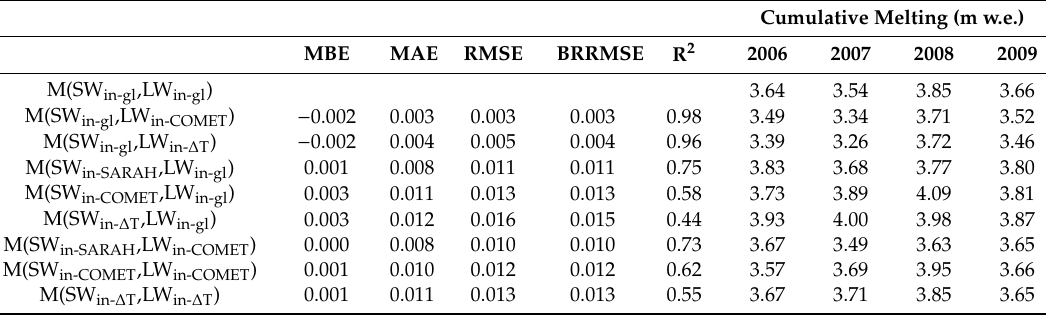
Table 3. MBE, MAE, RMSE, BRRMSE, and R 2 obtained comparing daily melt from Equation (11) estimated by means of di ff erent combinations of estimated short- and long-wave incoming radiation values with the one modeled using measured incoming radiation data values (SW in-gl and LW in-gl ). The table also shows the cumulative summer (June–August period) melting (m w.e.) from